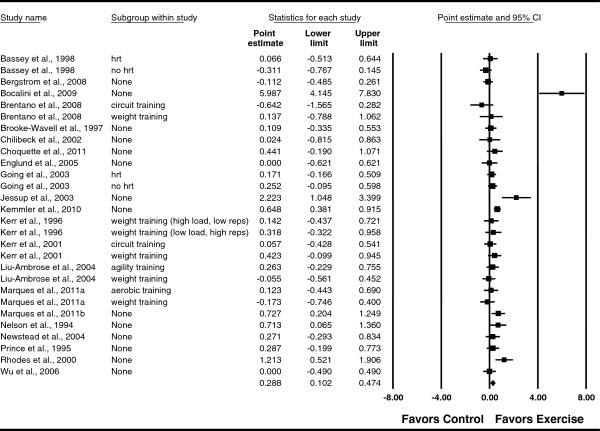
Forest plot for changes in FN BMD. Forest plot for point estimate standardized effect size changes (g) in FN BMD. The black squares represent the standardized mean difference (g) while the left and right extremes of the squares represent the corresponding 95% confidence intervals. The middle of the black diamond represents the overall standardized mean difference (g) while the left and right extremes of the diamond represent the corresponding 95% confidence intervals. For subgroup, HRT means hormone replacement therapy.